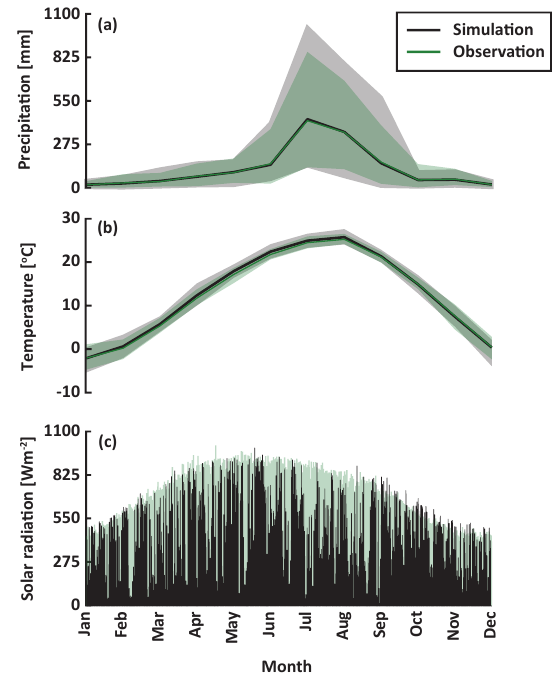
Figure 1. Observed (green) and reproduced (black) weather forcing data. A total of 50 years of hourly weather data were reproduced using a stochastic weather generator based on observations from 1986 to 2015. The 50th percentile (lines) and 5th to 95th percentile intervals (shaded areas) of the multi-year ensemble are shown for: ( a ) monthly precipitation, ( b ) monthly temperature, and ( c ) hourly solar